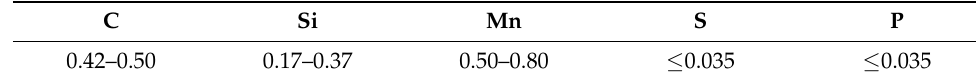
Table 2. Chemical composition of welding wire (wt. %). Table 1. Chemical composition of 1045 steel (wt. %).